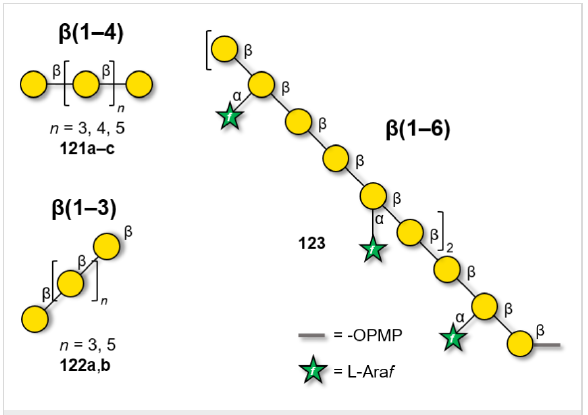
Figure 10: Examples of type I and type II galactans synthesized to date.